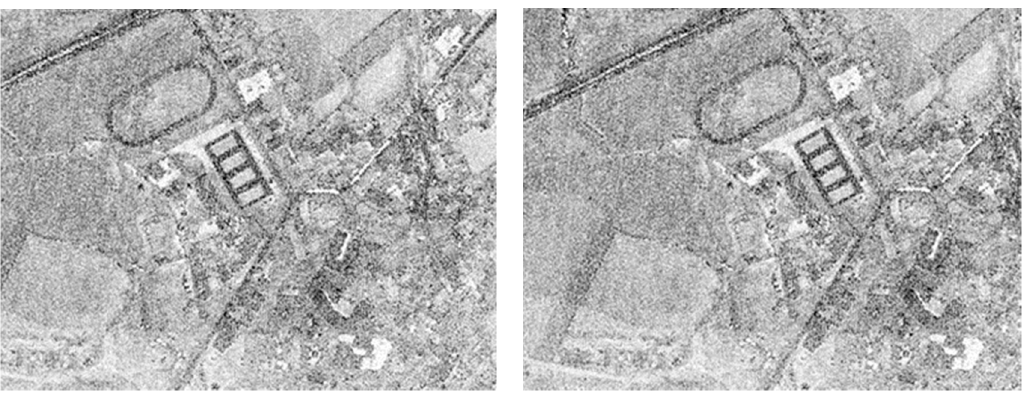
Figure 6. Synthetic model of intensity generated for a LiDAR point